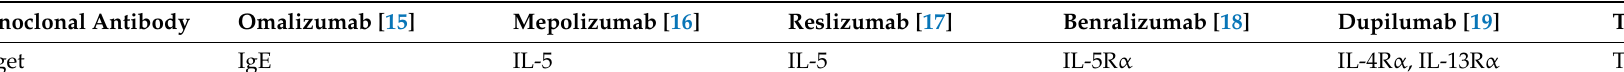
Table 1. Biologics currently approved for the treatment of severe uncontrolled asthma. (TSLP = thymic stromal lymphopoietin, EoE Eosinophilic Esophagitis; EG/EGE: Eosinophilic Gastritis/Eosinophilic GastroEnteritis; COPD: Chronic Obstructive Pulmonary Disease; BP: Bullous pemphigoid; HES: Hypereosinophilic syndrome; EGPA: Eosinophilic Granulomatosis with Polyangiitis; NCFB: Non-Cystic Fibrosis Bronchiectasis; CSU: Chronic Spontaneous Urticaria). §